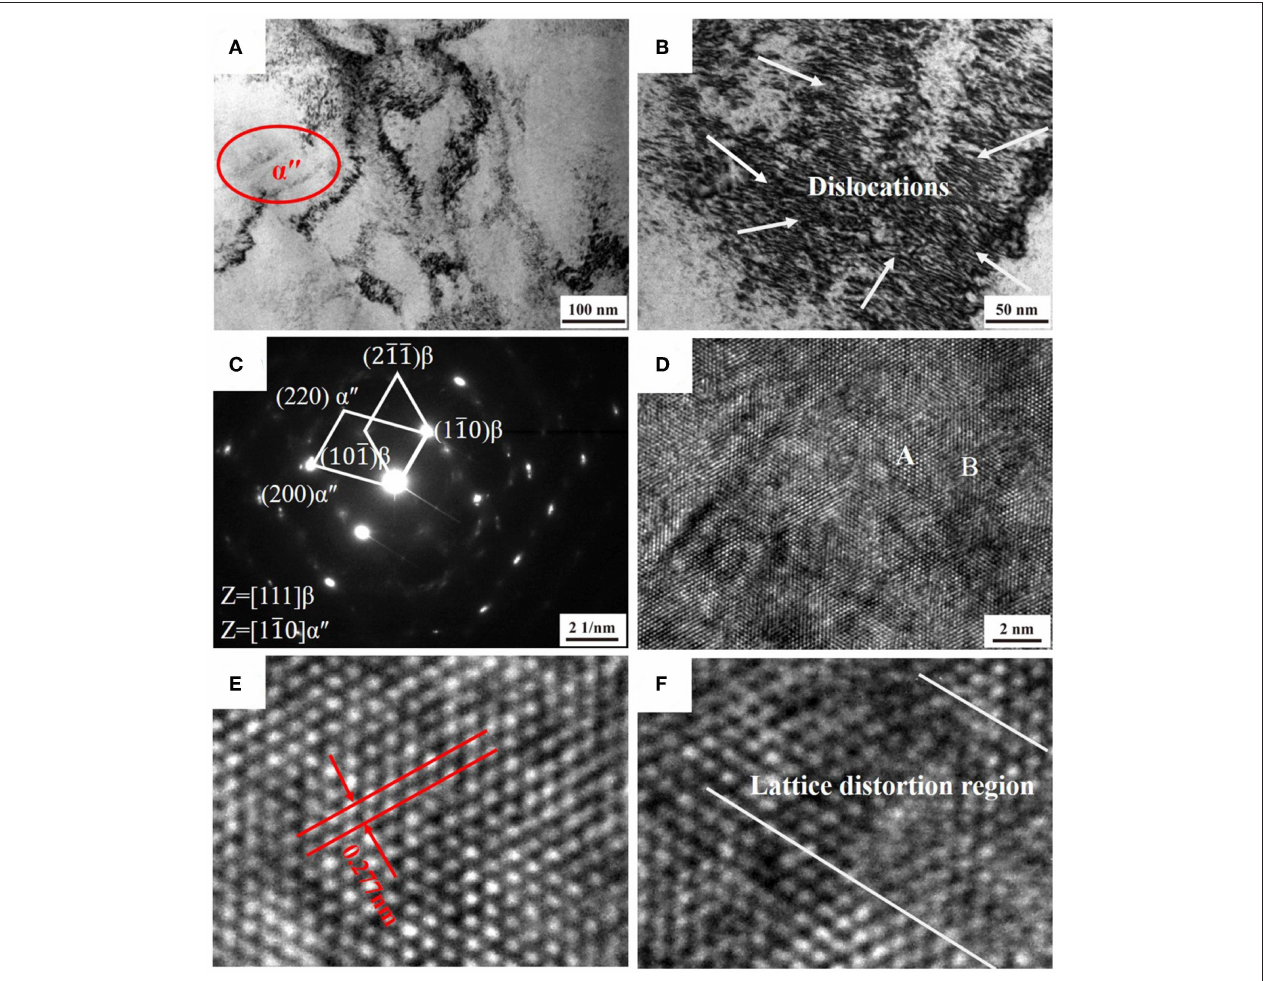
FIGURE 4 | TEM and HRTEM micrographs: (A) bright-field micrograph of laser-quenched Ti-35Nb-2Ta-3Zr alloy; (B) image of dislocation structure; (C) SAED patterns of (A) ; (D) HRTEM image shown along the [111] β zone axis; (E,F) are magnified HRTEM figures of the region A and B in (D) ,